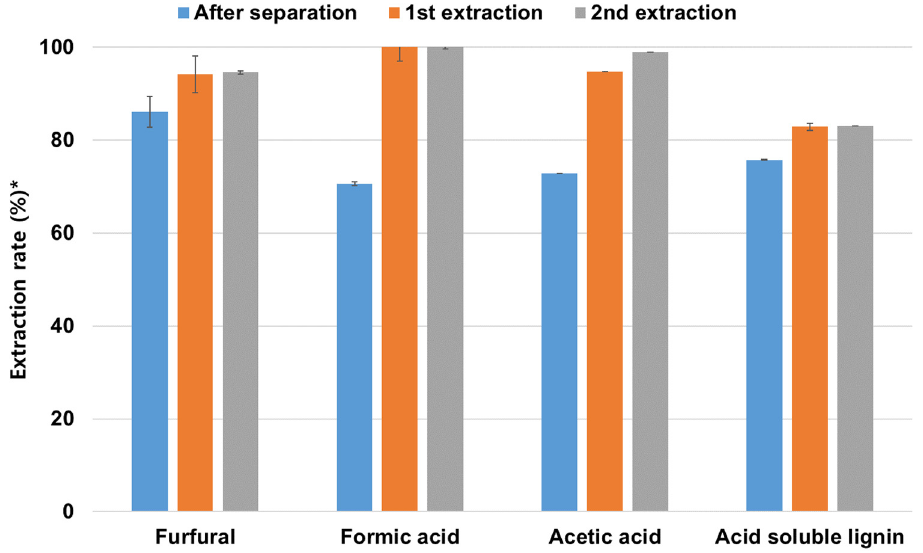
Figure 2. Extraction rate of products in furfural generated hydrolysate by extracting solvent (THF).